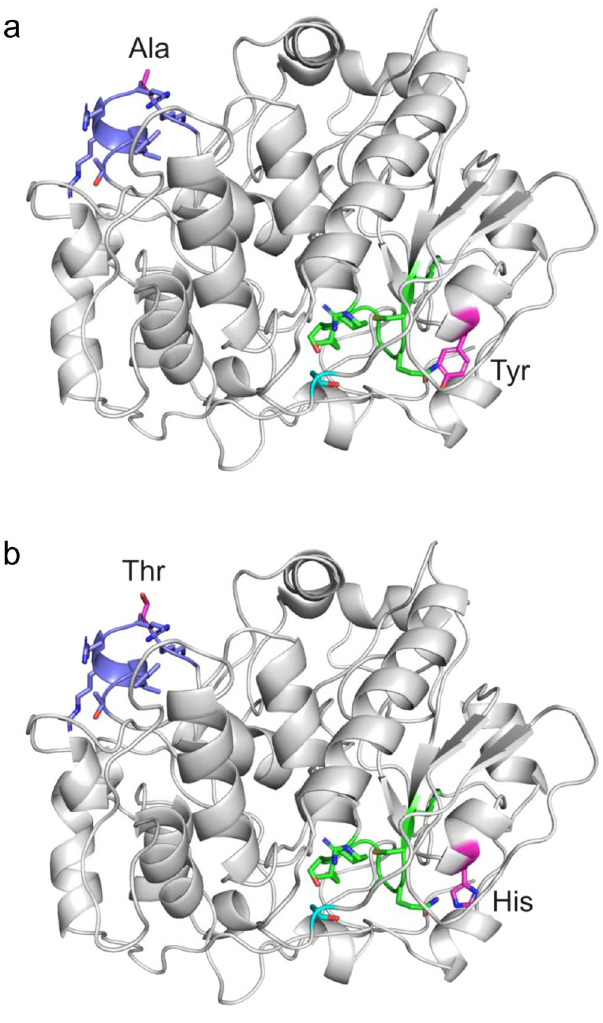
Fig. 3 DUSP1 homology model showing (a) the wild-type protein, (b) the mutated protein. Eczema-associated variants change the amino acids (in pink) at positions 56 (alanine, Ala, to threonine, Thr) and 187 (tyrosine, Tyr, to histidine, His). The kinase-interacting motif (blue), the phosphotyrosine- binding loop (green), and Asp227 (light blue) which belongs to the catalytic site are indicated. Acid and base groups in the functional sites are marked red and blue